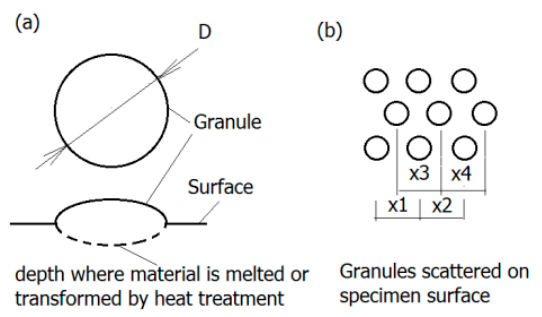
Figure 6. Granular surface: ( a ) Geometry of granules—The region of melted and transformed material is marked dashed line; ( b ) granules displacement on the surface (according to [78]).